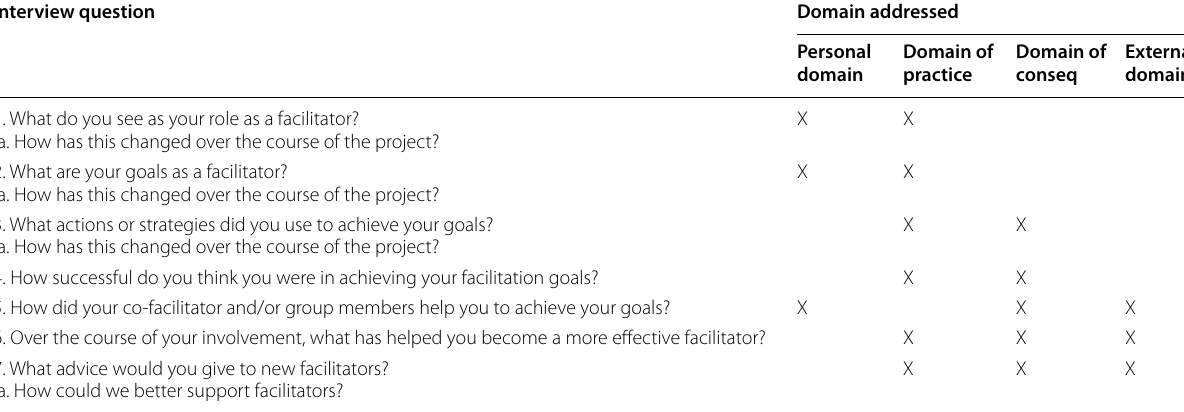
Table 1 Interview questions and the IMPG domain addressed